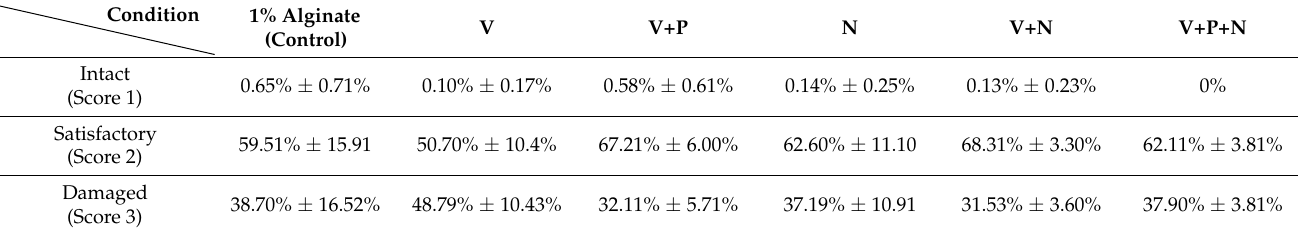
Table 2. Impact of NP supplementation on seminiferous tubule integrity 5 days after grafting.